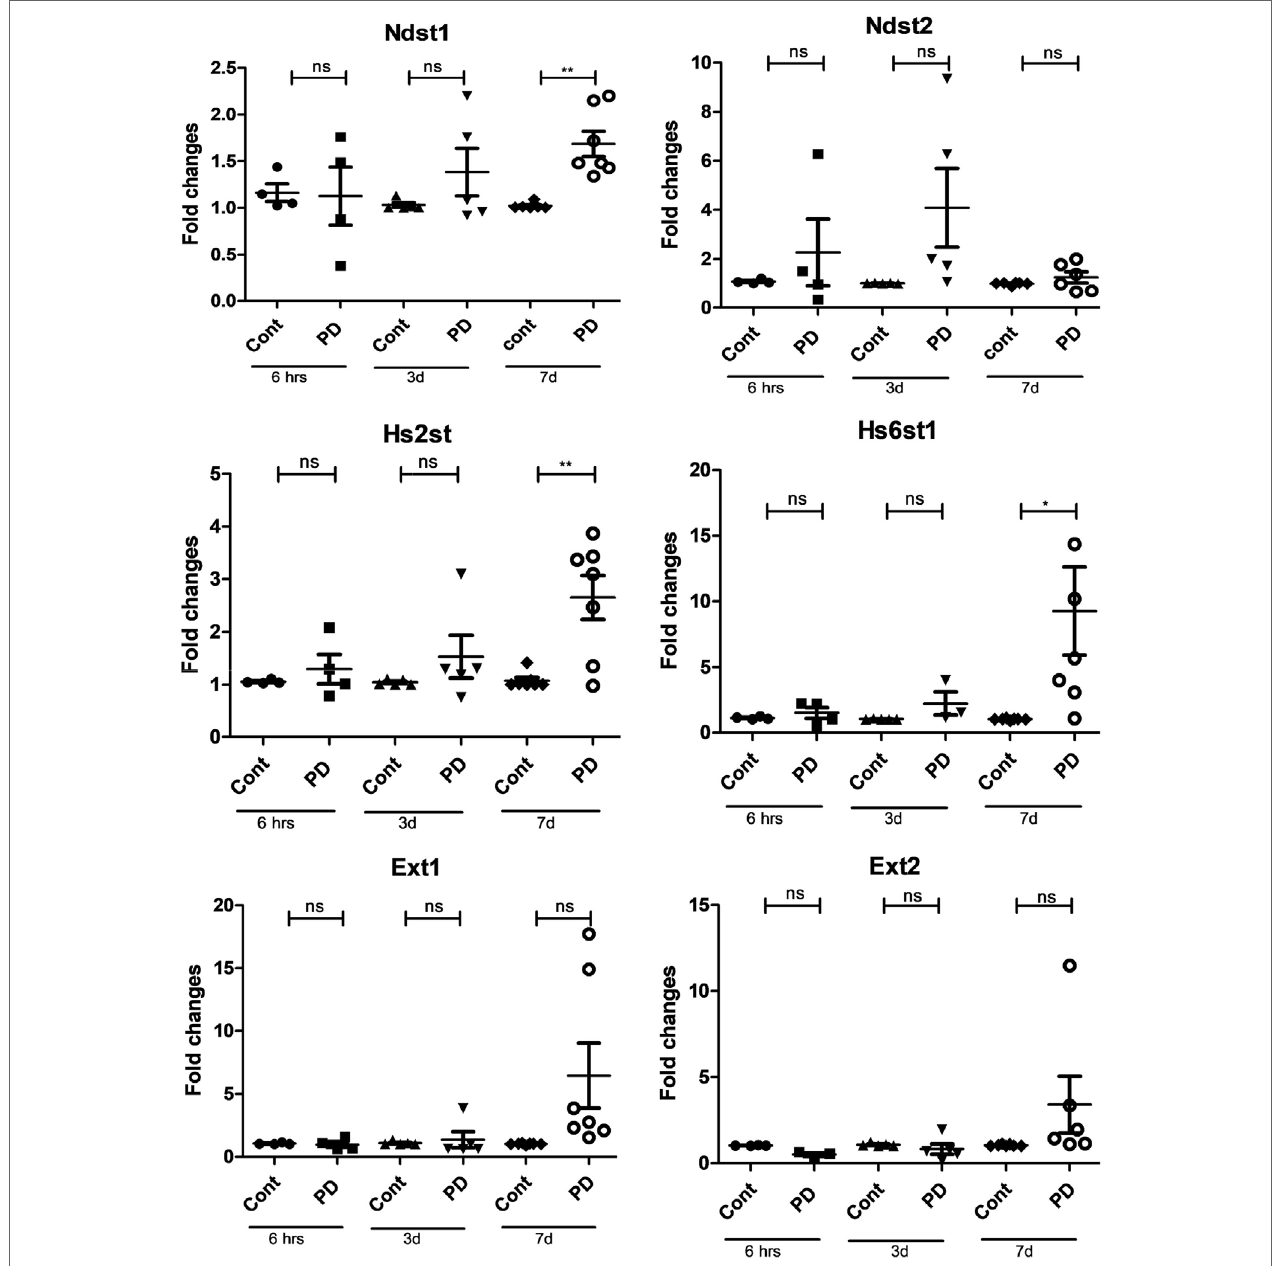
FigUre 3 | Mitogen-activated protein kinase signaling regulates the expression of genes involved in sulfation of heparin/heparan sulfate. Bone marrow-derived mast cells (0.5–1.0 × 10 6 cells/ml) were incubated with 50 µM PD98059 (PD) for various time periods (6 h–7 days) as indicated. Total RNA was then prepared and analyzed by qPCR for the expression of Ndst1, Ndst2, Hs2st1, Hs6st1, Ext1, and Ext2 as indicated ( n ≥ 4). Data were pooled from all experiments; at least four biological replicate experiments were performed, and each experiment was performed in triplicates (* p ≤ 0.05, ** p ≤ 0.01, *** p ≤